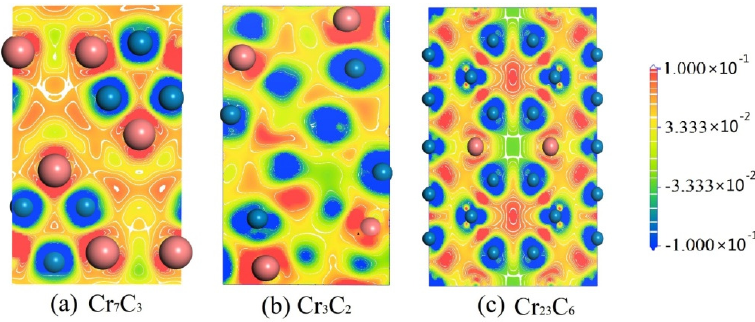
Figure 7. The charge density difference of three binary chromium carbides.